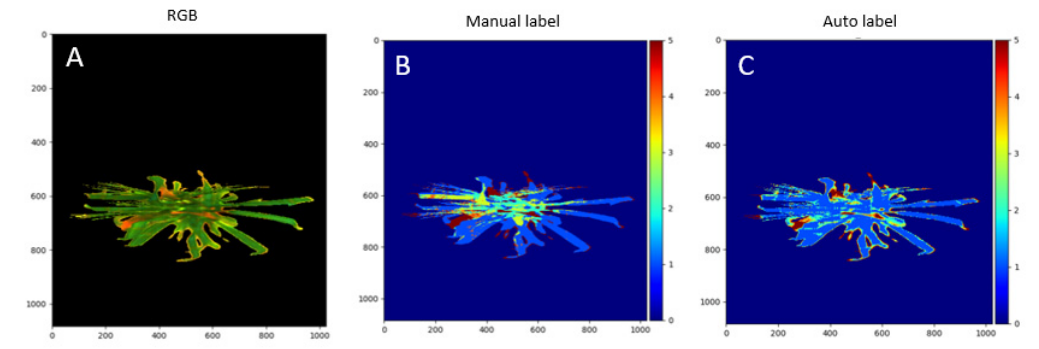
Figure 7. Comparison for durum wheat of the performances of the manually labelled model ( B ) with the automatically labelled model ( C ) with the red, green, and blue (RGB) representation of the hyperspectral image ( A ). Both the manually and automatically labelled datasets were fed into a logistic regression model, obtaining classification accuracies of 86.42% and 96.66% for the manual and automatic models, respectively. The color bar represents the label given by the automatic labelling algorithm.